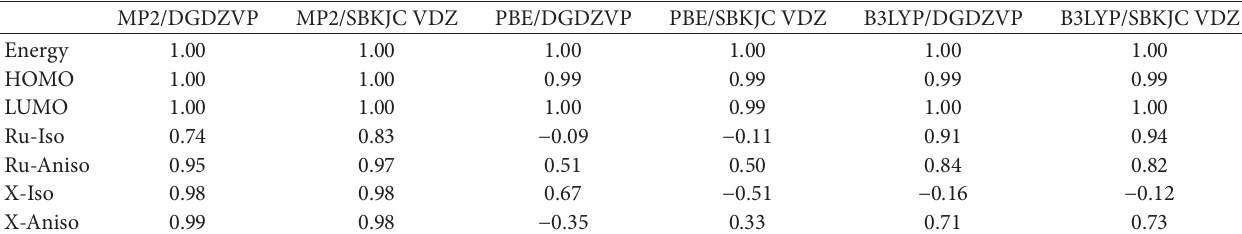
Table 6: Correlation of other methods of computation with the MP2/acc in computing energy, HOMO, LUMO, and isotropic and anisotropic shielding.